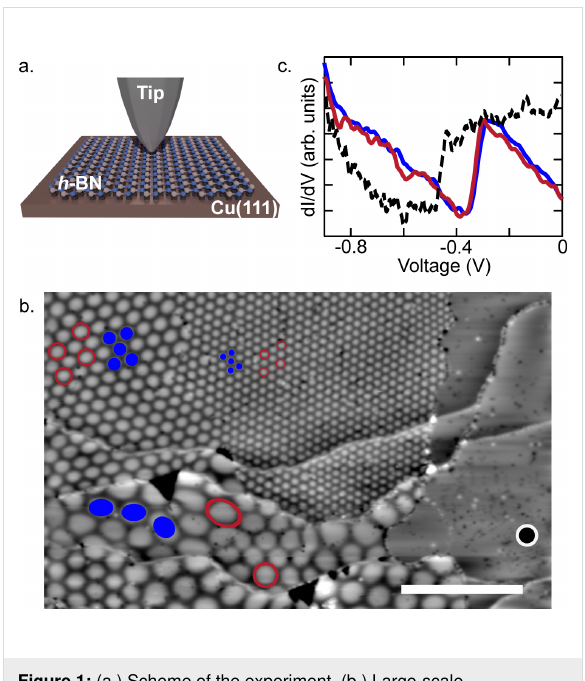
Figure 1: (a.) Scheme of the experiment. (b.) Large-scale (200 × 125 nm 2 ) constant-current ( I = 20 pA, V = 3.7 V) STM topogra- phy of h -BN/Cu(111) and the bare Cu(111) surface. Blue circles and red rings mark exemplary valley and rim areas, respectively. (c.) Differential conductance d I /d V spectra taken at rim (red line) and valley (blue line) sites and at the bare Cu(111) substrate (dashed black